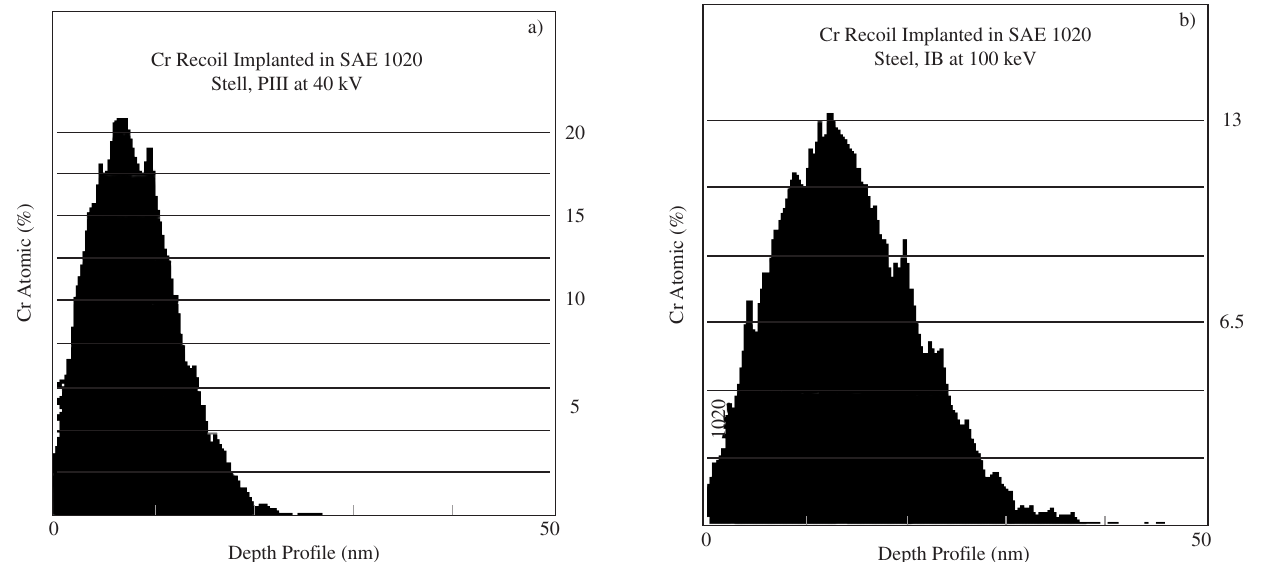
Cr Recoil Implanted in SAE 1020 Stell, PIII at 40